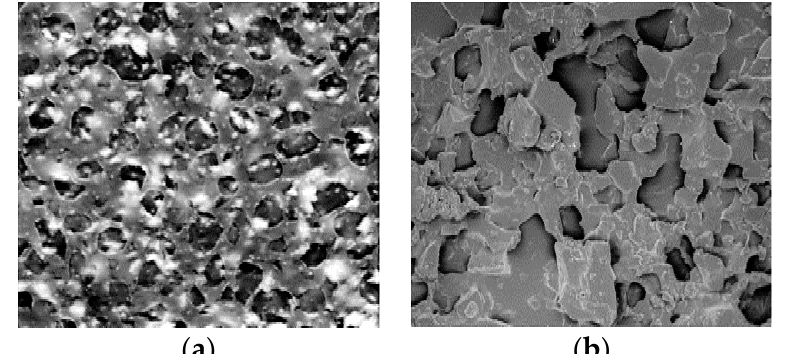
Figure 1. SEM micrographs showing the surface morphology of MIM prepared by embedding of nanoMIP particles in a CA membrane ( a ) and its corresponding NIM ( b ). Reproduced with permission [22].